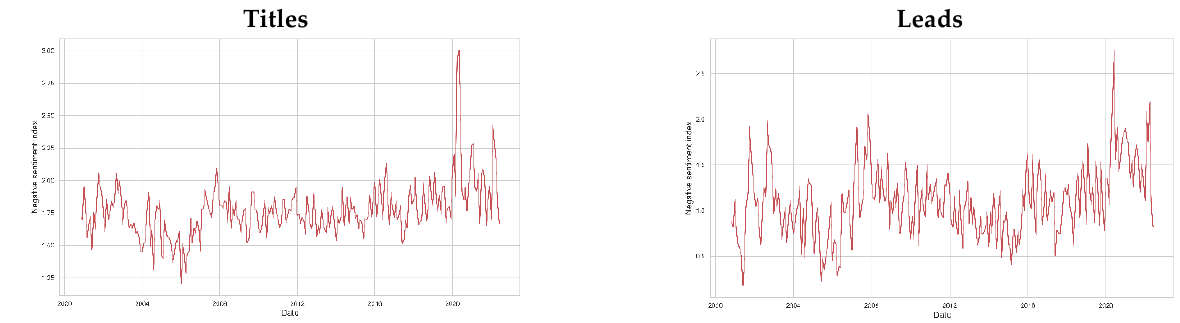
Figure A5. Sentiment analysis of news titles and leads over time for category “ Culture ” news.